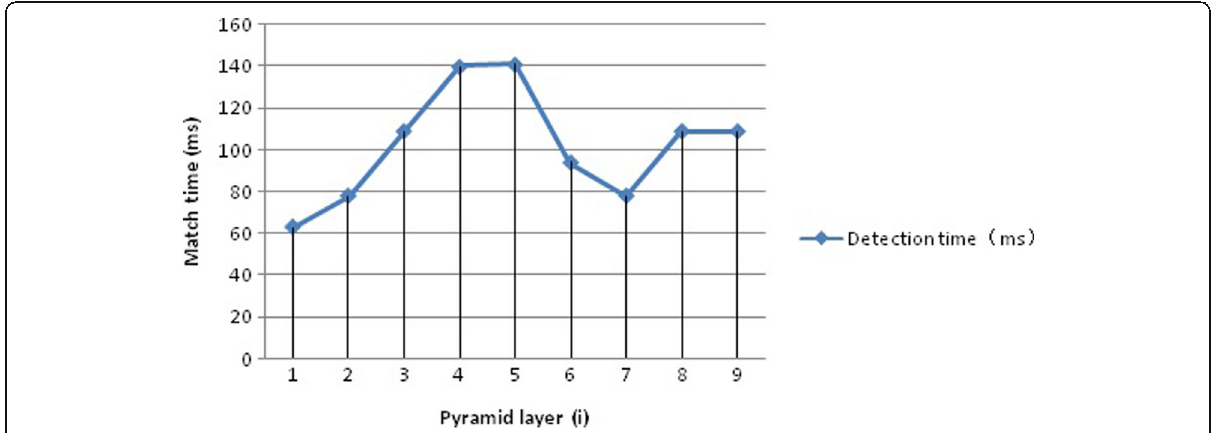
Fig. 29 Pyramid layer change and matching time relationship